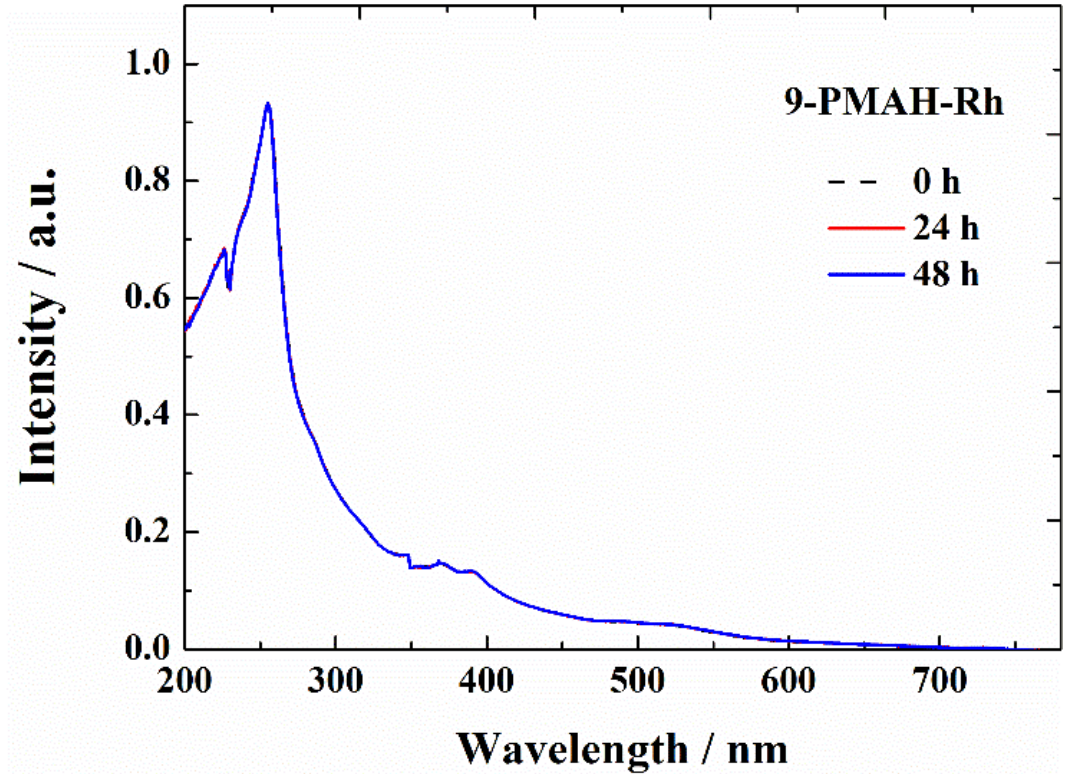
Figure 5. UV–Vis spectrum of 9-PMAH-Rh, showing its stability over 48 h in Tris buffer solution at room temperature.